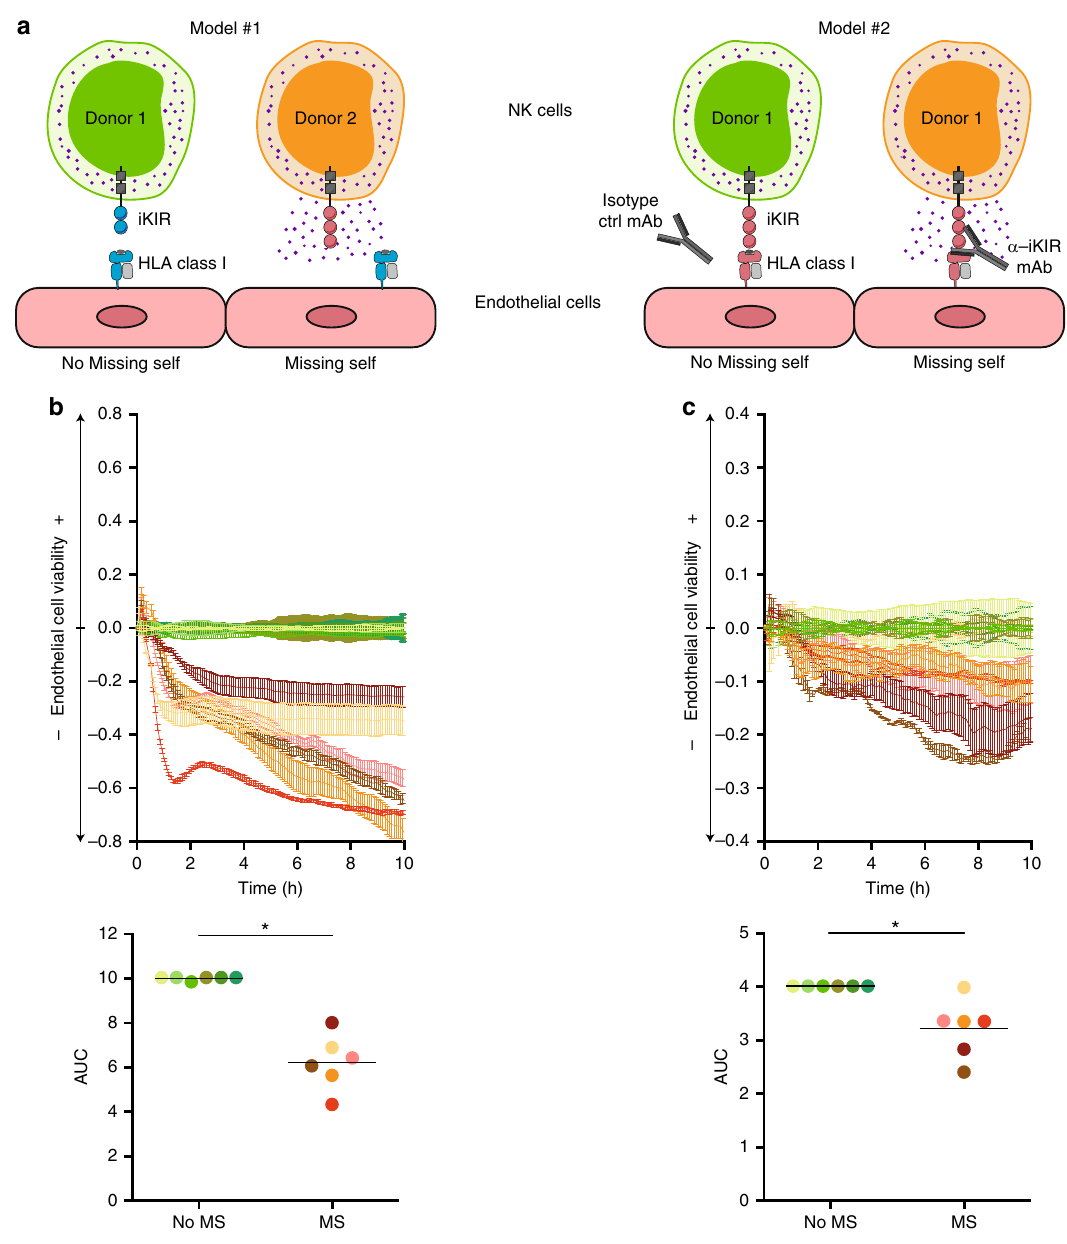
Fig. 5 Missing self-induced NK cell activation is harmful for endothelial cells. a Schematic representation of the two experimental models. Puri fi ed NK cells from healthy volunteers were co-cultured with adherent primary allogeneic human endothelial cells, the viability of which was assessed by real-time impedance measurement. Real-time impedance data of the experimental co-culture were normalised over control. b Model #1: The same primary human endothelial cells were co-cultured with NK cells puri fi ed from two distinct donors: the fi rst without missing self (control co-culture) and the second with missing self (experimental co-culture). Individual impedance pro fi les (mean ± standard error; upper panel) and the area under the curves (lower panel) from six independent experiments are shown. c Model #2: The same primary human endothelial cells were co-cultured with NK cells puri fi ed from a donor without missing self, in the presence of a blocking anti-inhibitory KIR mAb (experimental co-culture) or an isotype control mAb (control co-culture). Individual impedance pro fi les (mean ± standard error; upper panel) and area under the curves (lower panel) from six independent experiments are shown. * p < 0.05; Wilcoxon signed rank In a fi rst set of experiments (model #1, presented in Fig. 5a), we compared the survival of the same primary allogeneic ECs exposed to NK cells from two distinct donors: one with missing self and the other without (negative control). The experiment, reproduced with six different pairs, demonstrated that endothelial cell survival was consistently reduced when co-cultured with NK cells expressing one inhibitory KIR unable to interact with the appropriate HLA I molecules on ECs (Fig. 5b).